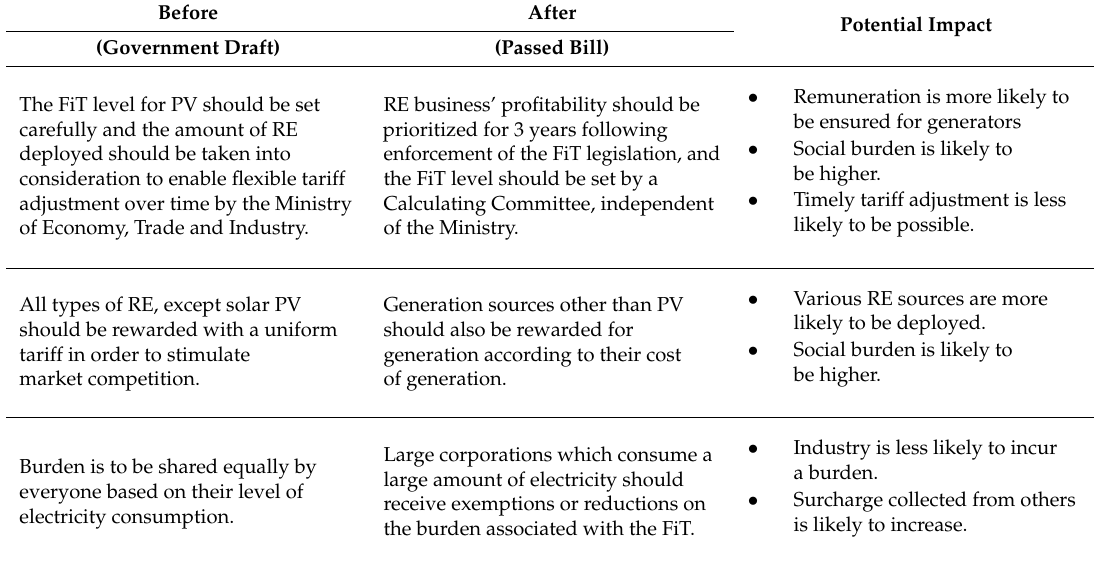
Table 4. Concepts Revised in the Legislative Procedure and Consequential